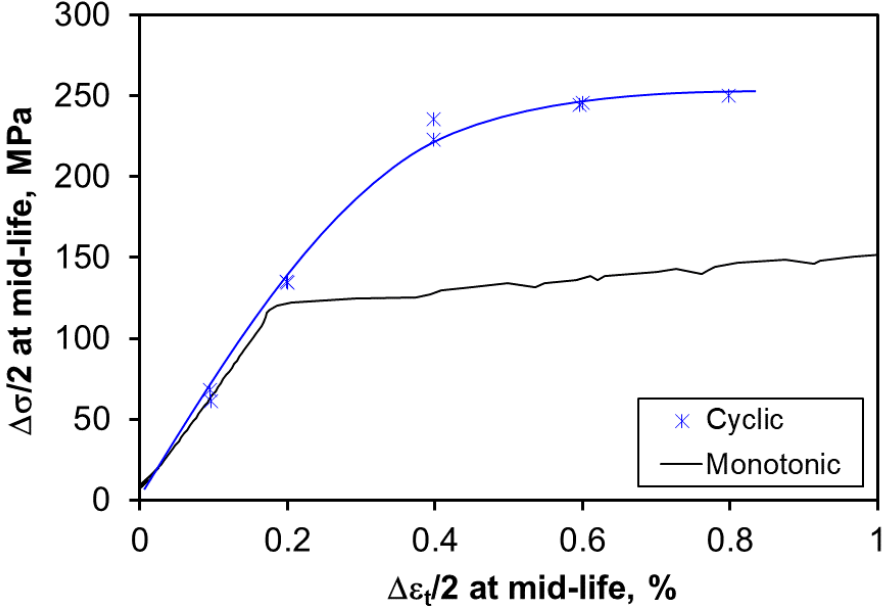
Figure 13. Cyclic stress–strain curve at mid-life of the heat-treated alloy vs. its monotonic tensile stress–strain curve.